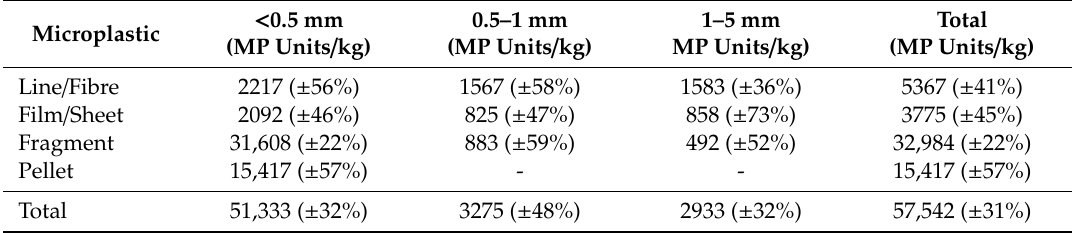
Figure 5. MPs identified as tyres. ( a , b ) Optical microscopy images; ( c ) SEM micrographs showing the morphology of this MP; and ( d ) Raman Spectra of tyre (used as comparison standard) and fragments from the sediments in the stormwater detention reservoir. Table 2. Characteristics of the MPs found in the sediment samples (30 g) from the SDR by shape and size (unit / kg). The relative standard deviation (RSD%) from n = X is given in brackets. < 0.5 Microplastic